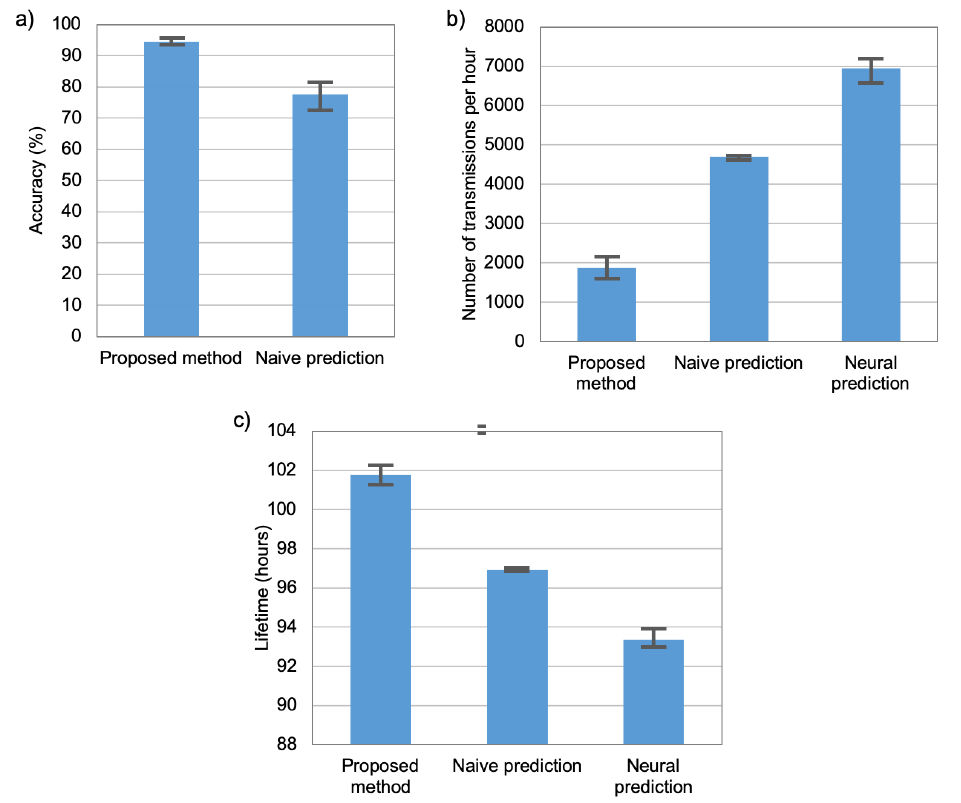
Figure 10. Comparison of accuracy ( a ), transmission number ( b ), and network lifetime ( c